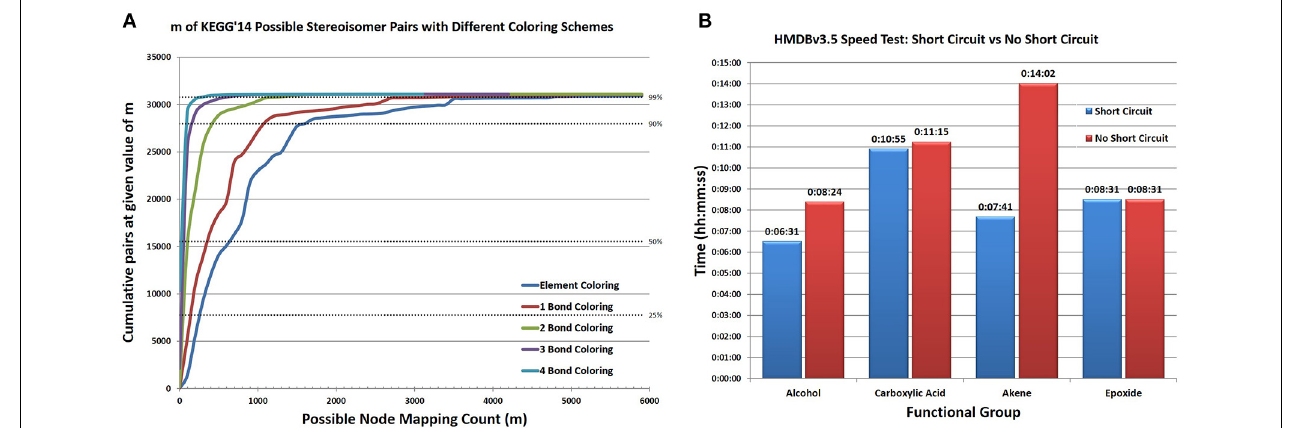
FIGURE 7 | Representative results of significant algorithmic improvements in CASS. (A) With element coloring only, the average number of mappings for each possible stereoisomer pair ranges from very small to very large, with 50% of pairs having an m greater than 700 and a maximum m of 25,219 (not shown in figure). Coloring using the element types connected within N bonds reduces m for almost all pairs. With 1 Bond coloring, 50% have an m greater than 400. A substantial improvement occurs between 1 bond and 2 bond coloring, with 50% having an m greater than 100 and a maximum m less than 6300. Incremental improvements in m occur for most compounds when N > 2. Using coloring schemes based on adjacent